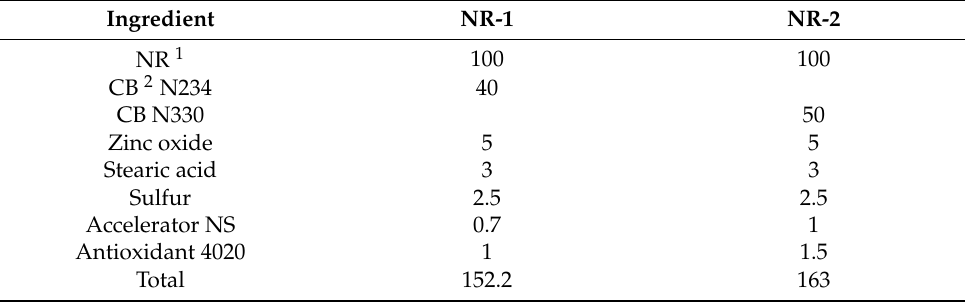
Table 1. Ingredient of the two types of carbon black filled rubber (UNIT: